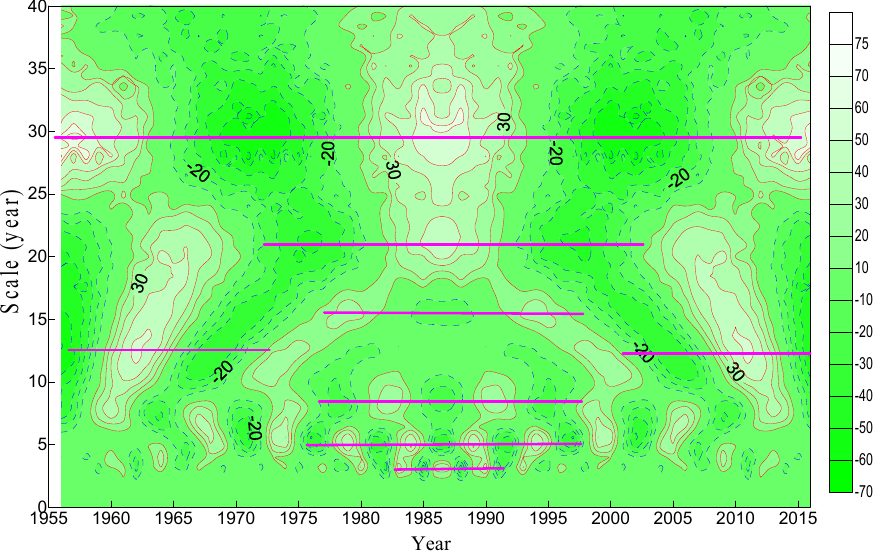
Figure 5. Real part coefficients contour map of streamflow at Tangnaihai station.